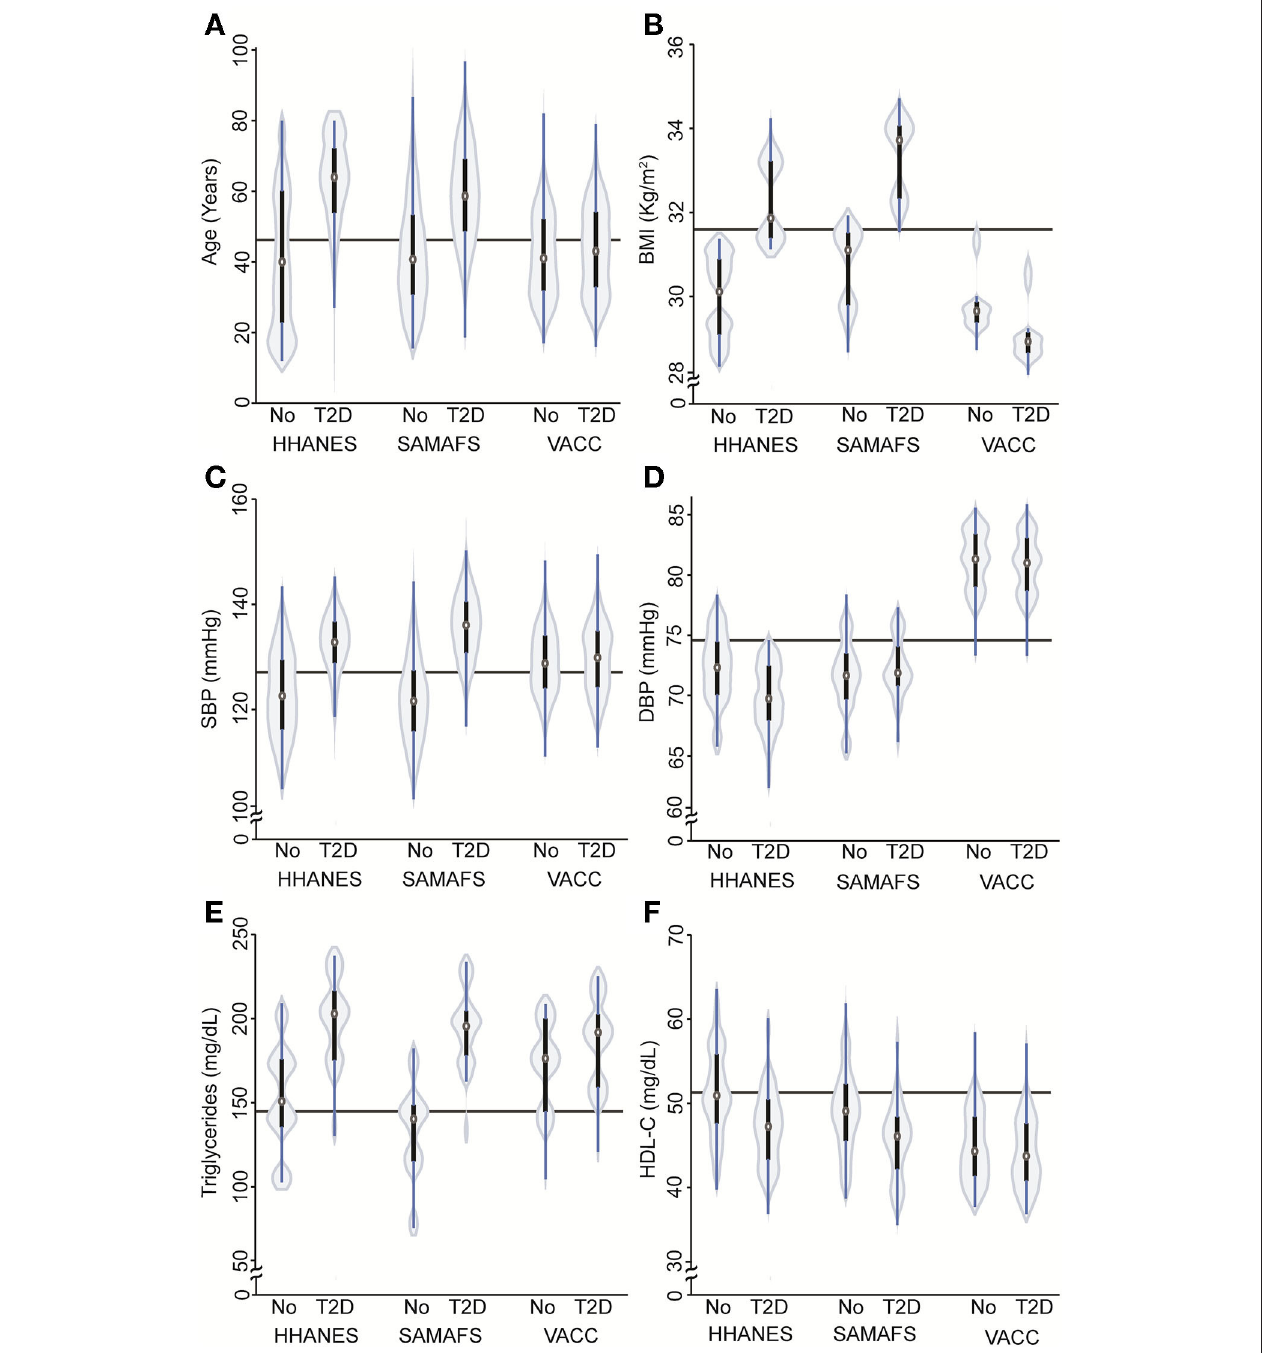
FIGURE 3 | Violin plots depicting the relationship between T2D status and various demographic and cardiometabolic traits in the VACC and HIV-1 negative HHANES and SAMAFS individuals. (A) Violin plot showing relationship between T2D status and age in the three cohorts. Participants with T2D were older than non T2D [ b = 13.1 (se 1.3), p < 0.001], but the VACC individuals showed interaction with T2D [ b = − 9.5 (se 1.9), p < 0.001]. (B) Violin plots showing relationship between age-, sex-, and cohort-adjusted BMI and T2D status in three different cohorts. Higher BMI was associated with T2D status [ b = 2.8 (se 0.45) p < 0.001] in HHANES and SAMAFS, but interaction between VACC and T2D shows lower BMI when compared with other cohorts [ b = − 3.5 (se 0.55) p < 0.001]. (C,D) Violin plots showing relationship between SBP and DBP adjusted by age, sex, cohort, BMI and T2D status. For VACC, there was an interaction seen for DBP [ b = 3.8 (se 1.0) p < 0.001], but not for SBP. (E,F) Violin plots showing relationship between triglycerides and HDL-C adjusted by age, sex, cohort, BMI and T2D status. T2D was associated with higher triglycerides concentrations [ b = 28.2 (se 12.3), p = 0.02] and lower HDL-C [ b = − 3.5 (se 0.9) p < 0.001]. The HDL-C showed interaction for VACC [ b = 2.2 (se 1.1) p = 0.042]. HHANES: The Hispanic component of NHANES 2018 cohort; SAMAFS, San Antonio Mexican American Family Studies; VACC, Valley AIDS Council Cohort. The continuous horizontal line represents the mean value without adjustment.